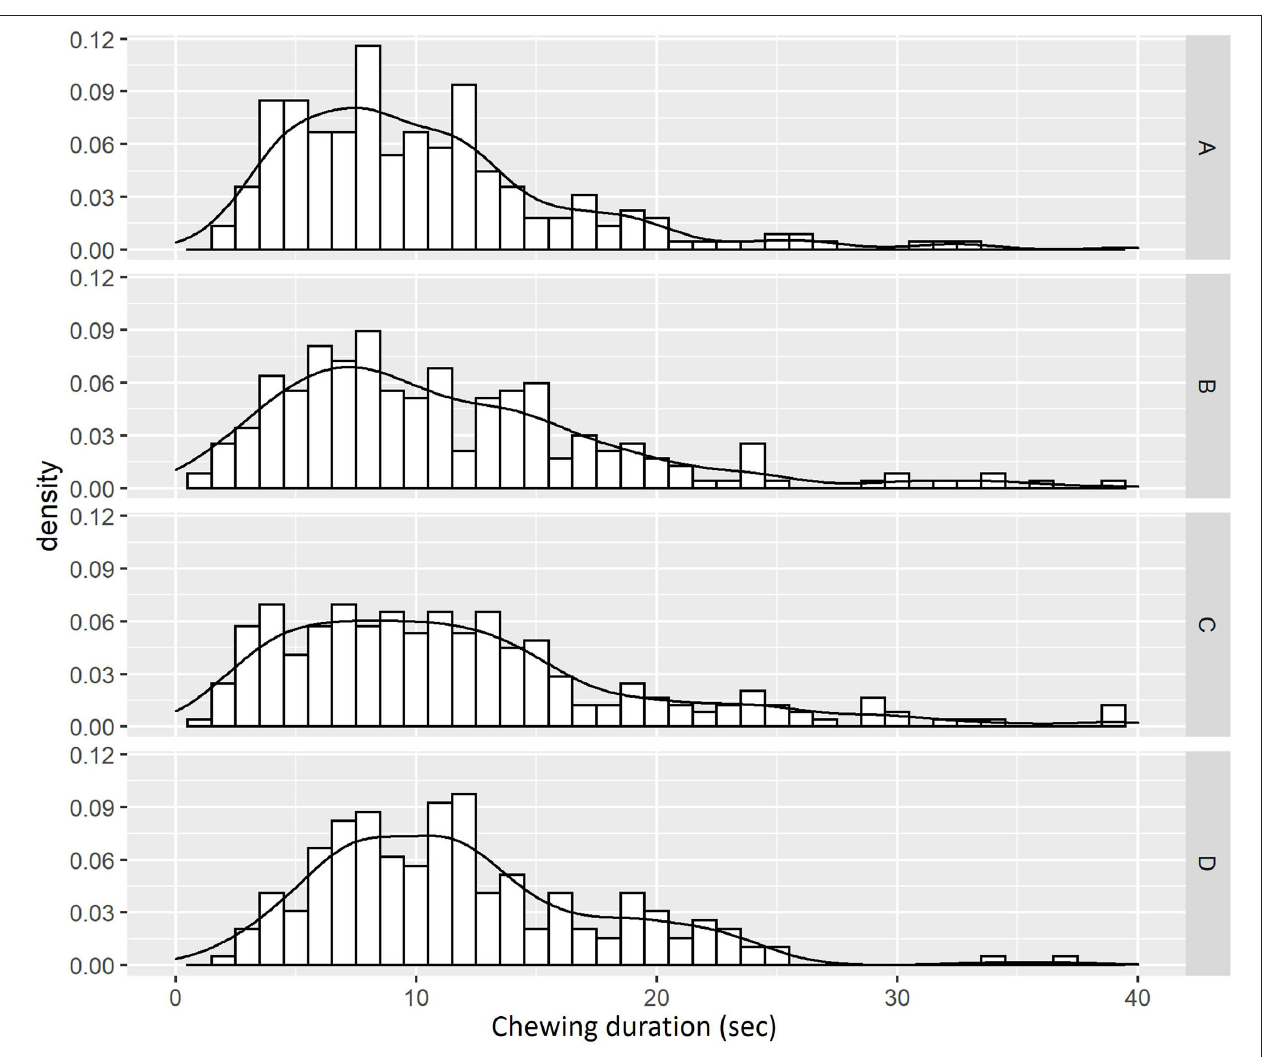
FIGURE 8 | Chewing length density of the participants using lunch box sets (A–D)